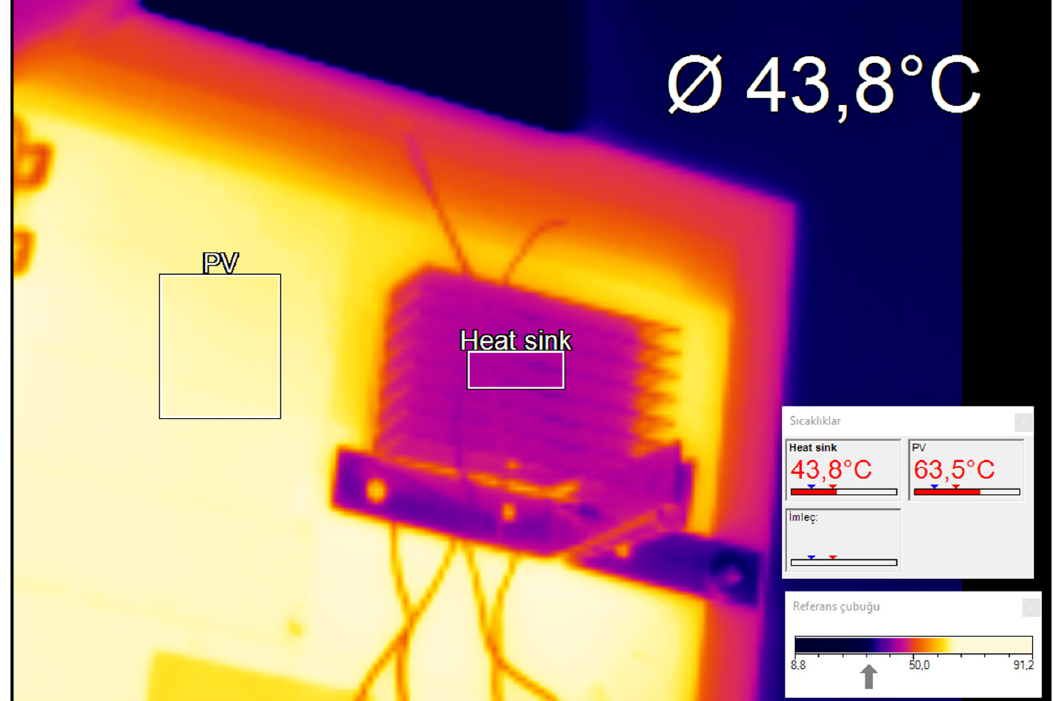
Figure 8. Thermal imaging of the photovoltaic panel with TEG prototype.